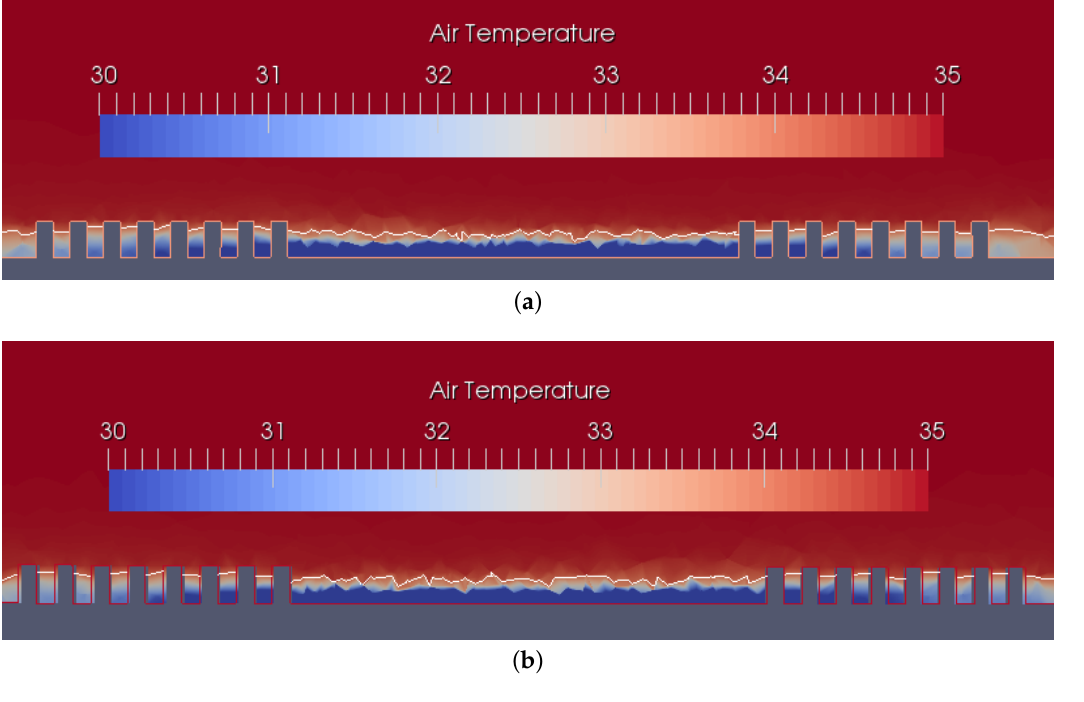
Figure 11. Vertical slice of the air temperature field for a low building density district. ( a ) UF 1: buildings are 10 m high; ( b ) UF 6: buildings are 17 m high)—the white line is the 34 °C